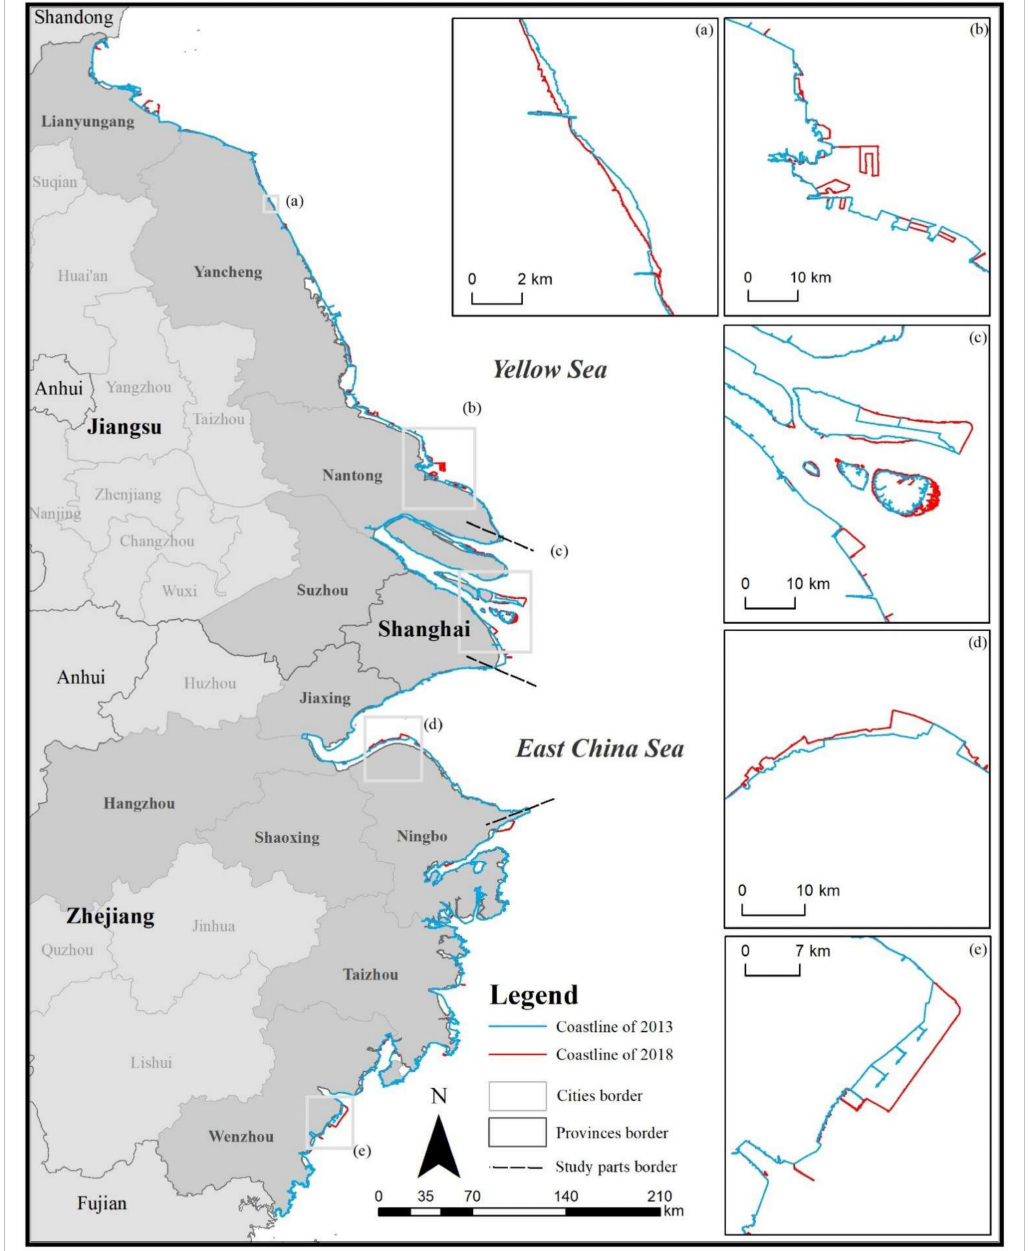
Figure 3. Extracted coastlines of Yangtze River Delta in 2013 and 2018: ( a ) port construction in Lianyungang city, ( b ) port construction in Nantong city, ( c ) reclamation construction and silt accre- tion in Yangtze River estuary, ( d ) reclamation construction in Ningbo city, and ( e ) reclamation in Wenzhou